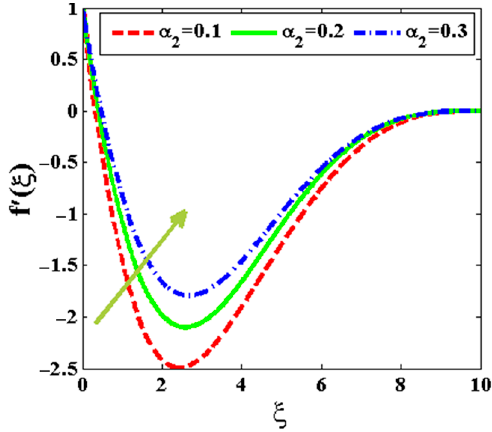
Figure 5. Outlines of 𝑓 ′ at diverse quantities of 𝛼 (cid:2870) .